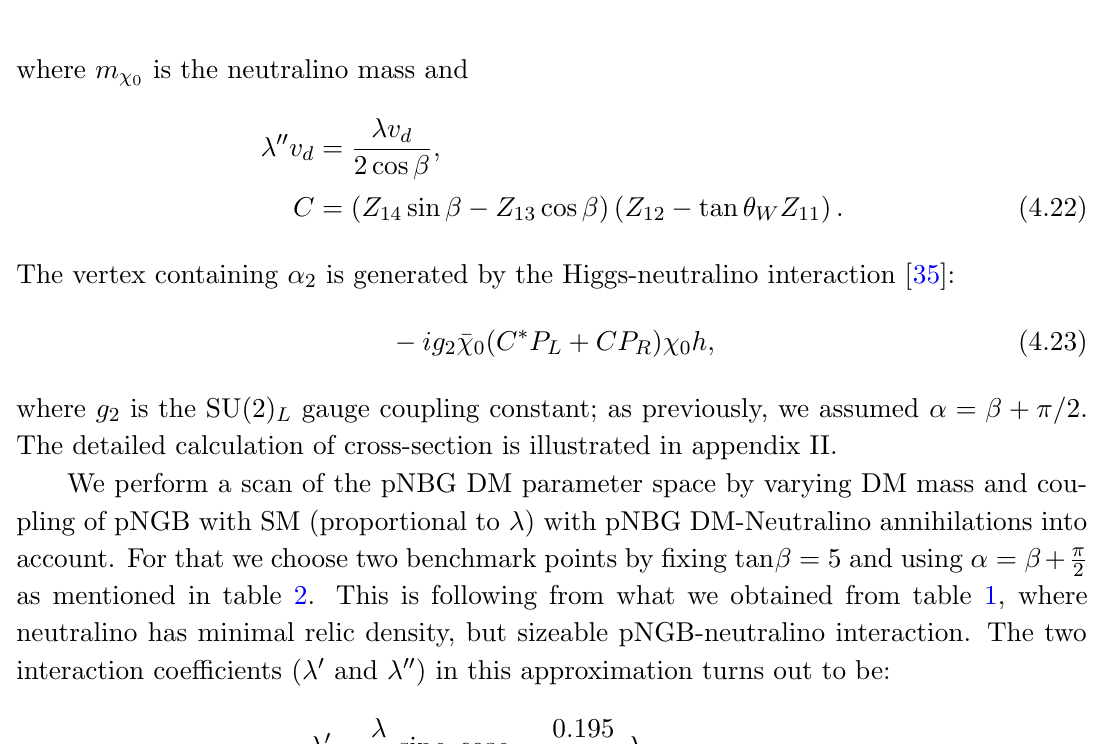
Figure 11 . A plot between C and Z 12 for tan (cid:12) = 5 assuming wino or wino-Higgsino dominated neutralino with Z 11 = 0 and Z 13 = Z 14 . Our choice ( Z 12 = 0 : 88 and C = 0 : 2) has been denoted by a red